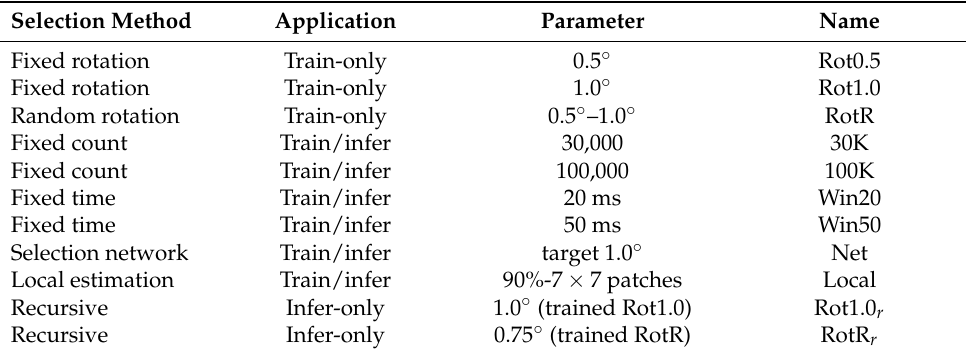
Table 1. Selection methods and motion estimation models used in the experiments.